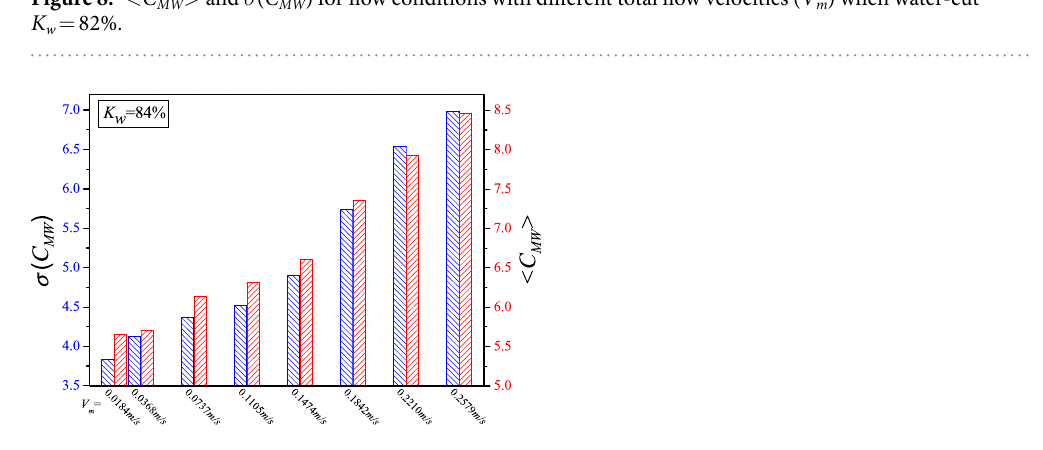
Figure 9. < C MW > and σ ( C MW ) for flow conditions with different total flow velocities ( V m ) when water-cut K w =